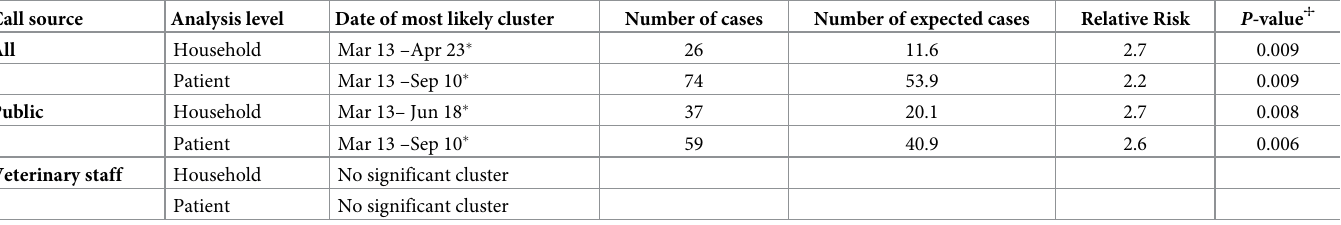
Table 3. Statistically significant results of unadjusted retrospective temporal scan statistics using a Poisson model examining calls to the APCC 1 involving reported dog and cat exposures to pet food products (January 1 –December 31, 2007). Call source Analysis level Date of most likely